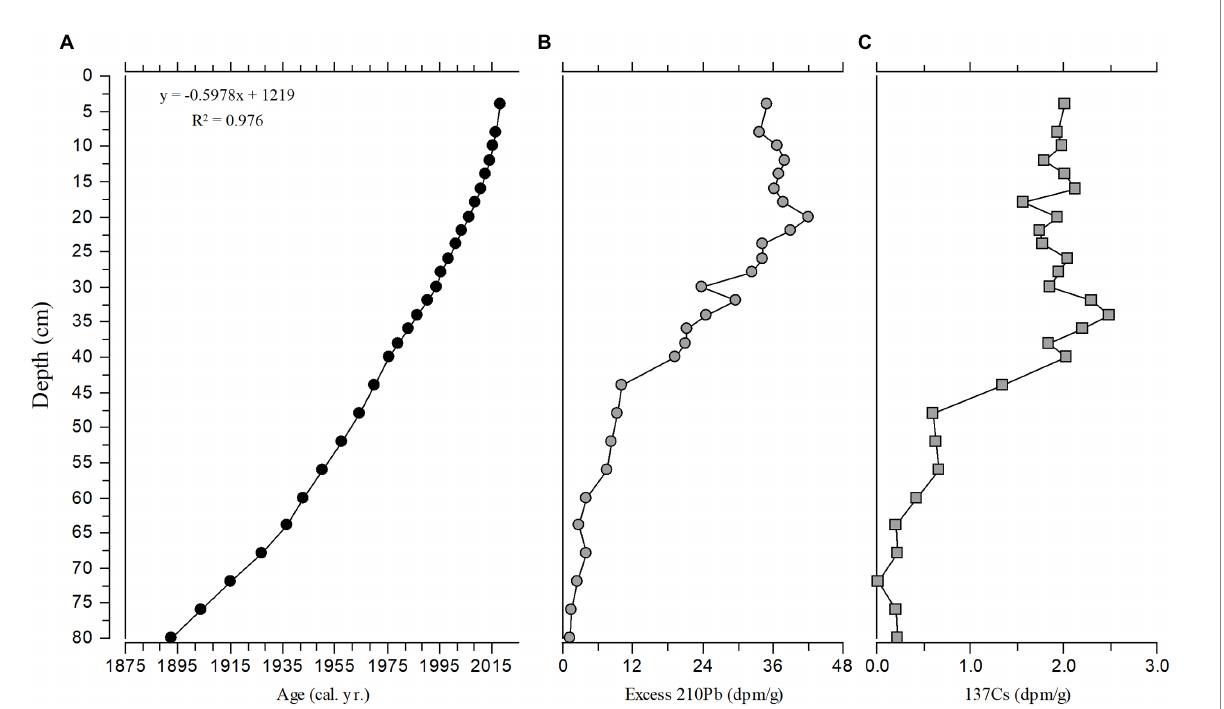
FIGURE 7 Stratigraphic plot for (A) Age, (B) Excess 210 Pb, and (C) 137 Cs with relationship to depth from the top 80 cm of the sediment core. Linear age vs. depth model is shown with the R 2